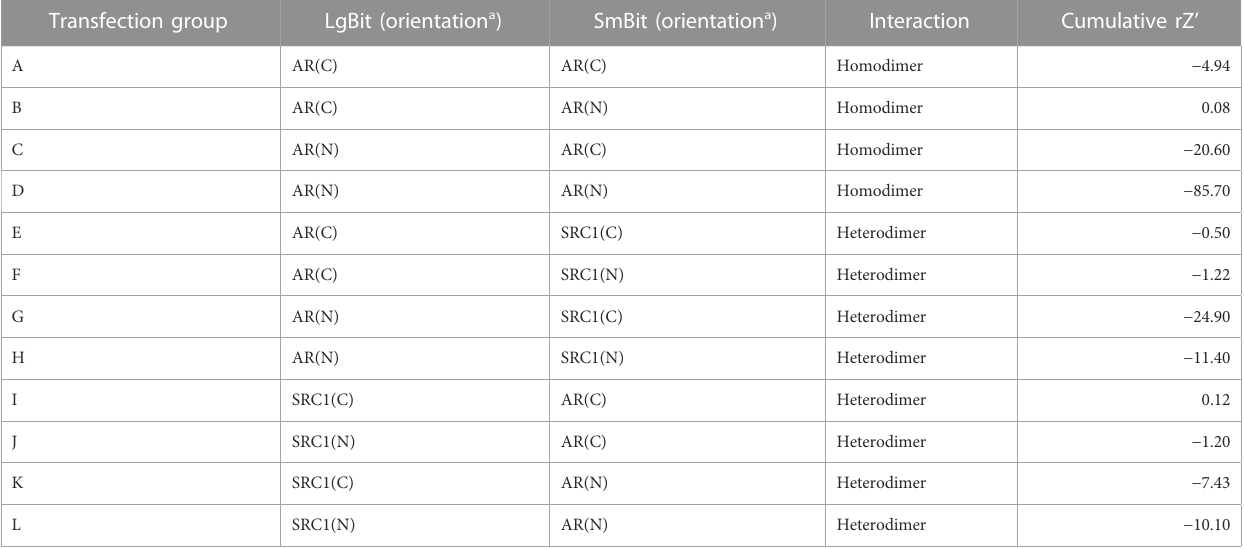
TABLE 1 Transfected NanoBit